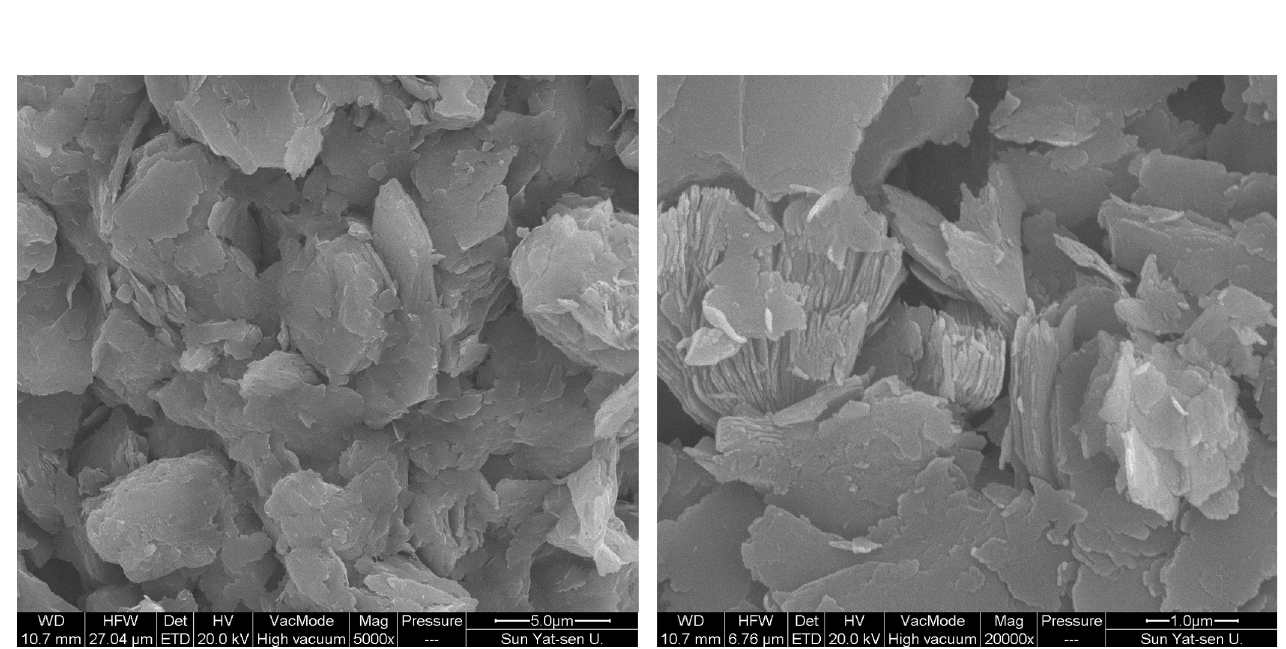
Fig 2. SEM Images of the Weathered Red-Bed Soil (A) Magnified view of 5000 times; (B) Magnified view of 20000 times.